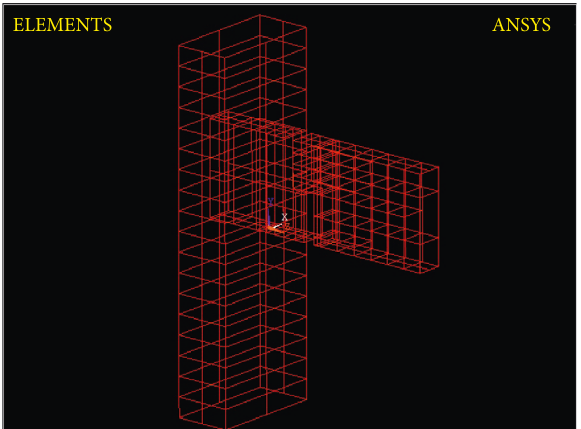
Figure 6: Reinforcing arrangement of beam-column joints. Figure 7: Finite element model of beam-column